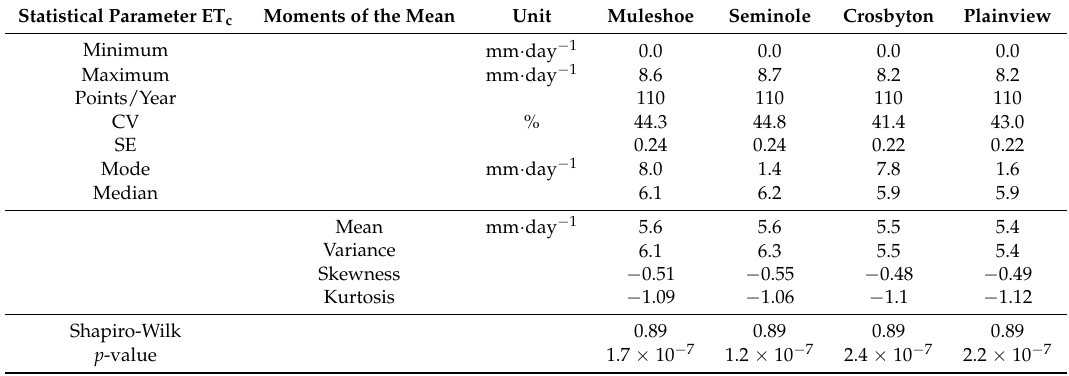
Table 2. Statistical parameters of calculated daily cotton ET (ET c ) values for the 30-year data set (1975–2004) for the four locations across the THP. Given are minimum, maximum, number of points per year, coefficient of variation (CV), standard error (SE), mode and median, and the moments of the mean, variance, skewness and kurtosis. The Shapiro-Wilk test for normality and corresponding p -value for each location are also